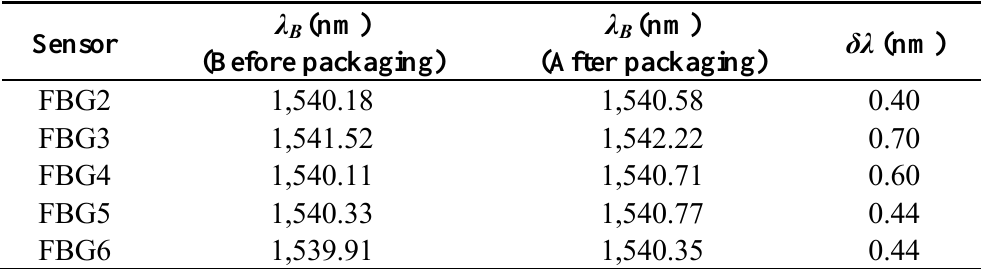
Table 1. Bragg wavelength position ( λ shift ( δλ ) induced by packaging for each FBG strain